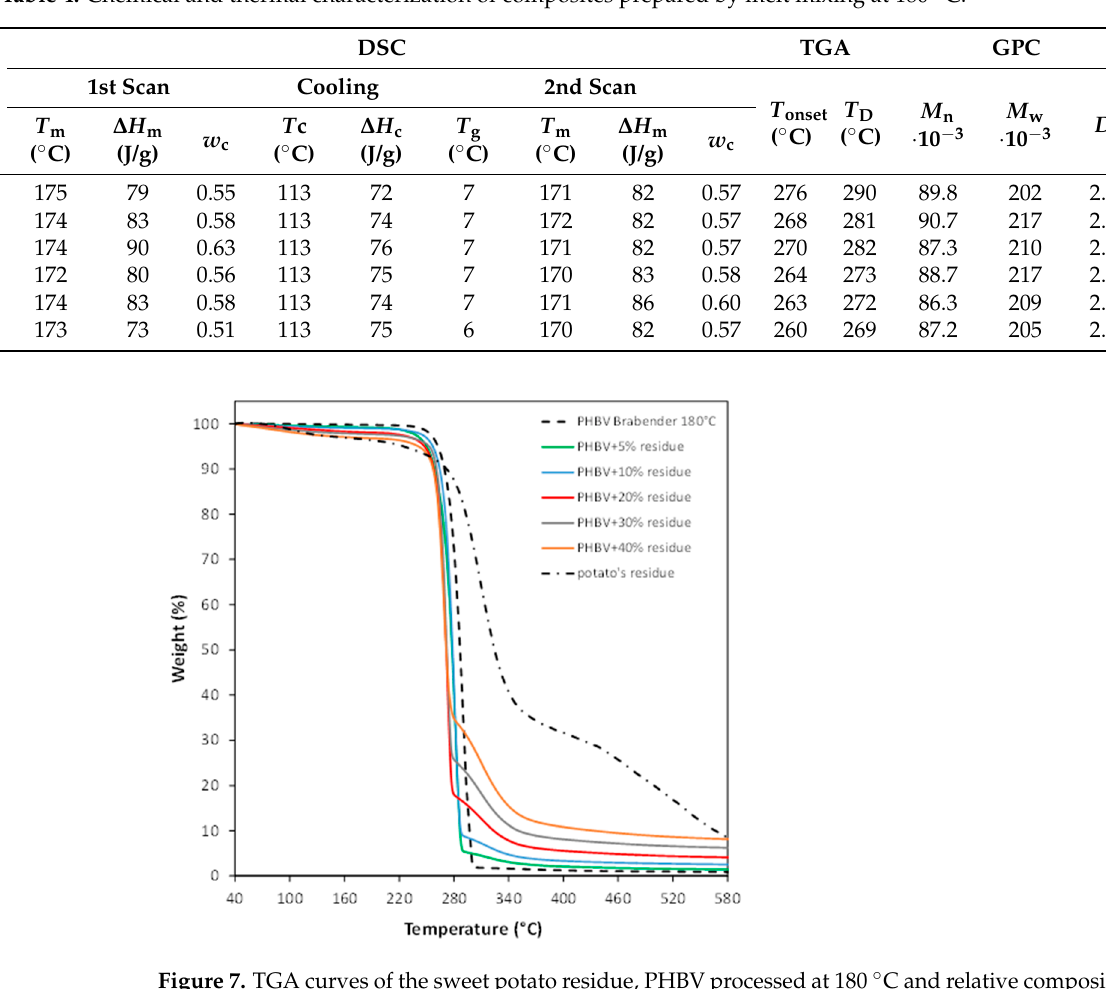
Table 4. Chemical and thermal characterization of composites prepared by melt mixing at 180 ◦ C.